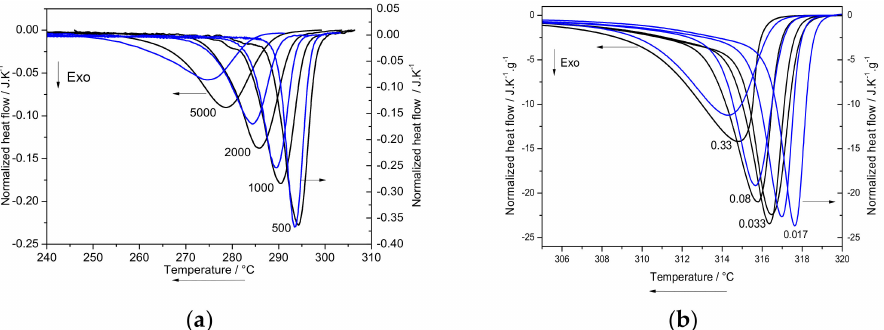
Figure 4. FSC ( a ) and DSC ( b ) heat flow normalized to cooling rate for non-isothermal crystallization from the melt at di ff erent cooling rates, considering samples with a mass of ~27 ng and ~4 mg respectively. Black: PTFE, blue: PTFE / SiO 2 (c)F. The cooling rate of each experiment (in K · s − 1 ) is indicated by each